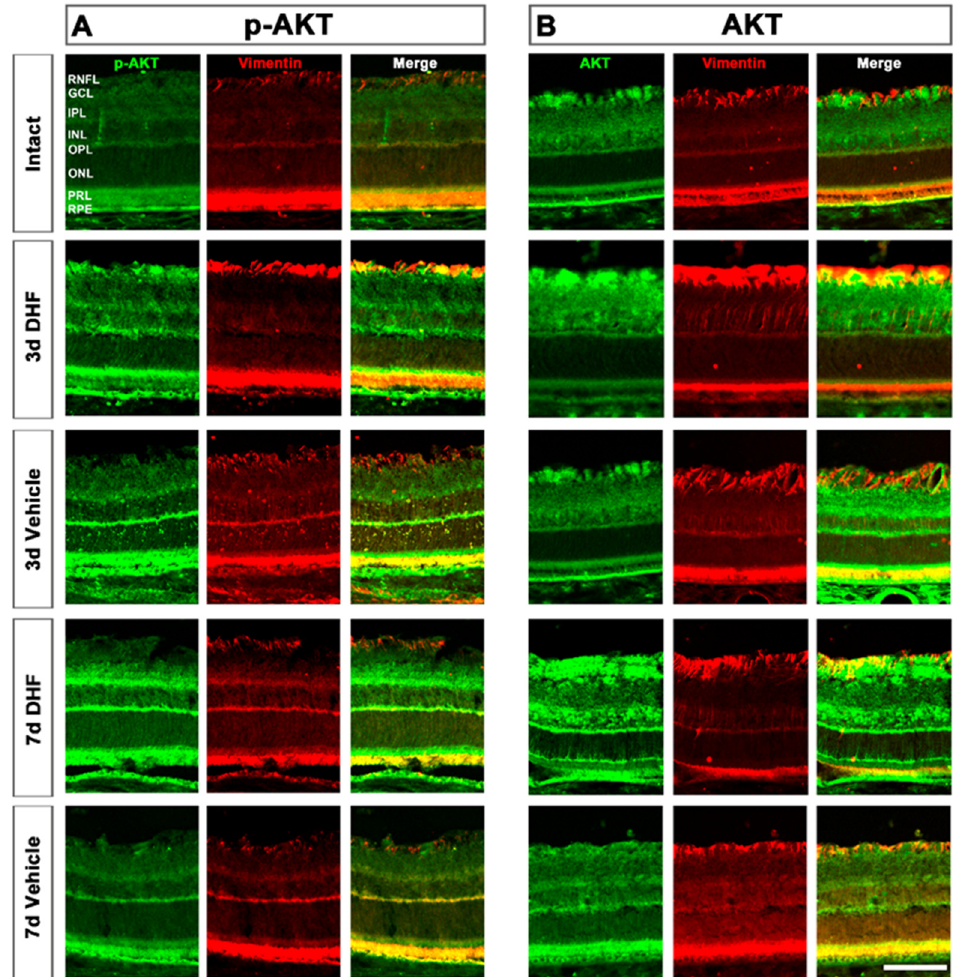
Figure 4. Activation of AKT signaling pathway in Müller cells (MCs). Representative micrographs (20 × ) of phosphorylated AKT ( A ) and total AKT ( B ) protein levels in intact, and axotomized retinas treated with DHF or vehicle at 3 and 7 days after IONT. The signal of each certain protein, MCs immunodetected with vimentin and the co-localization of both images are shown. RNFL = retinal nerve fiber layer, GCL = ganglion cell layer, IPL = inner plexiform layer, INL = inner nuclear layer, OPL = outer plexiform layer, ONL = outer nuclear layer, PRL = photoreceptor layer, RPE = retinal pigment epithelium. Scale bar at the bottom right = 50 µm.